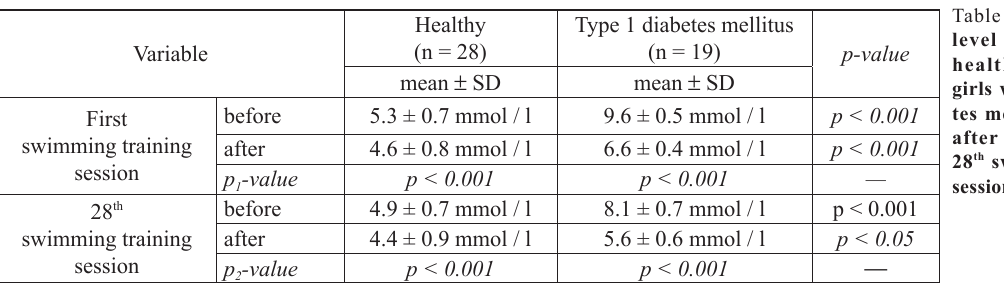
Table 3. Blood glucose level (mmol / l) of the healthy girls and the girls with type 1